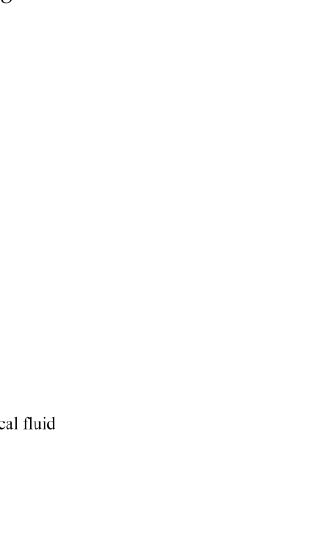
Figure 9. 3D structure of the designed VSB.